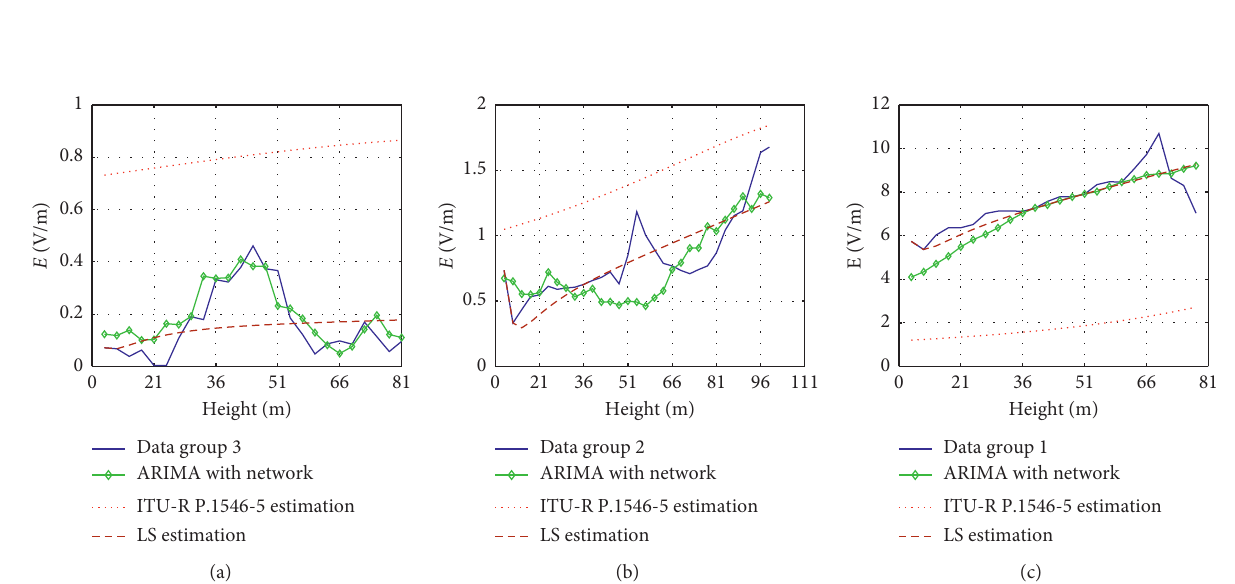
Table 11: ARIMA, ITU, and LS Relative and RMS errors for 􏽢􏽥 L